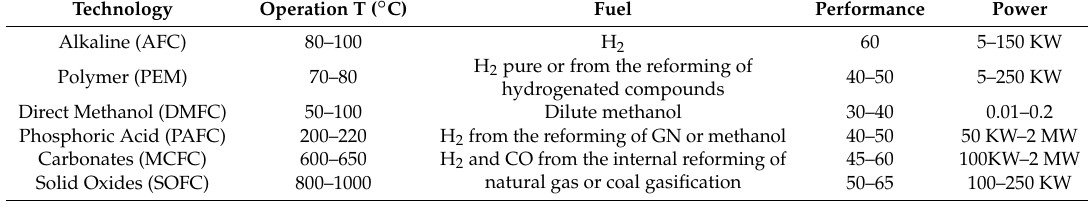
Table 3. Fuel cell types [11].